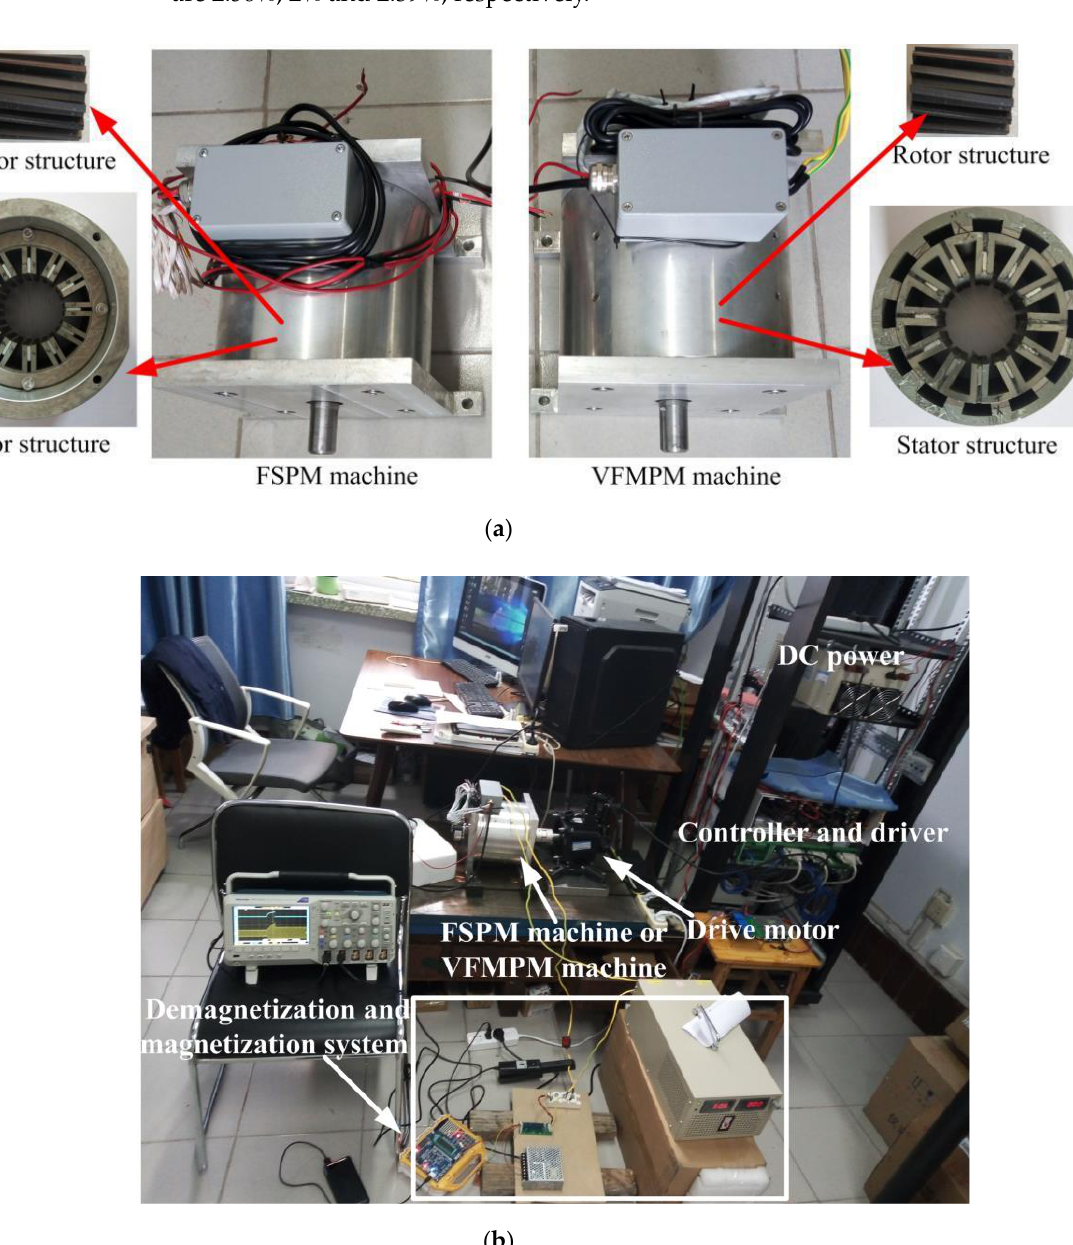
Figure 9. Prototype and test rig. ( a ) Prototype; ( b ) Test rig of back EMF waveforms.